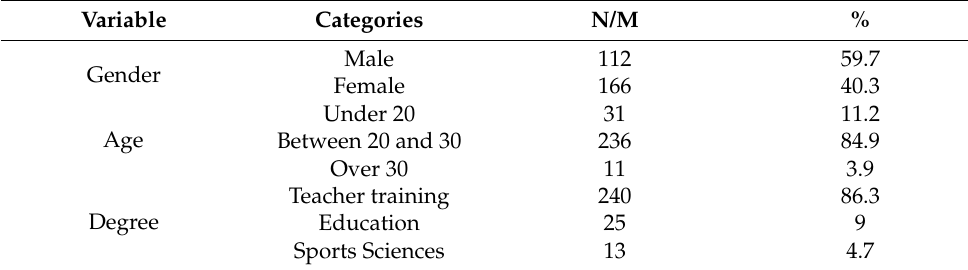
Table 1. Frequency distribution of the sample (N =